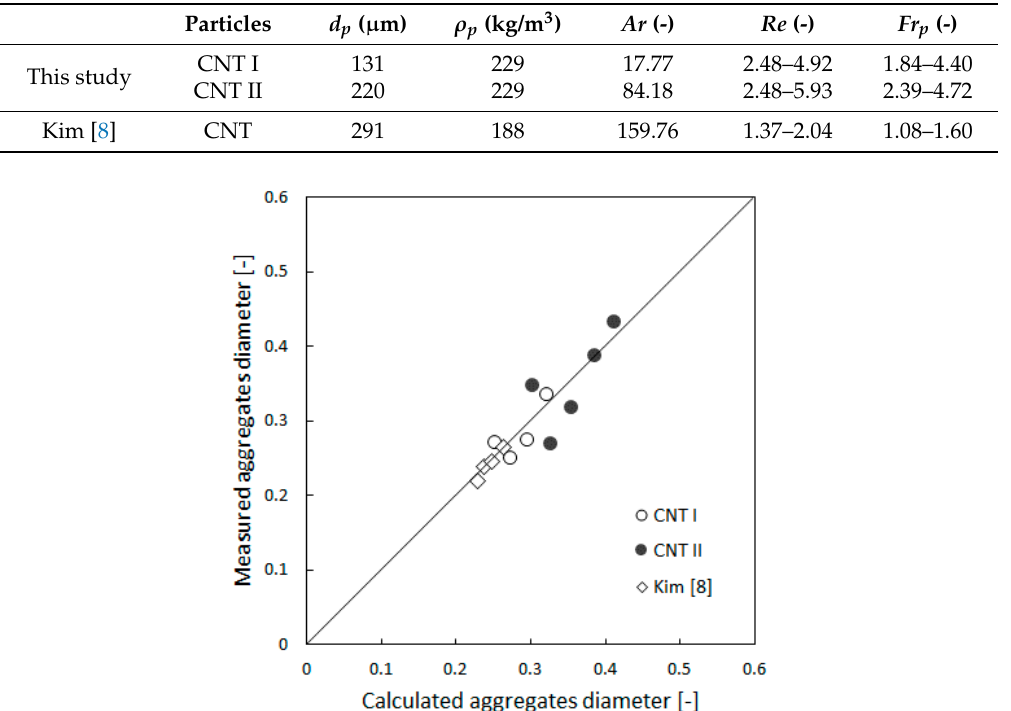
Table 1. A summary of experimental conditions of the present and previous studies.